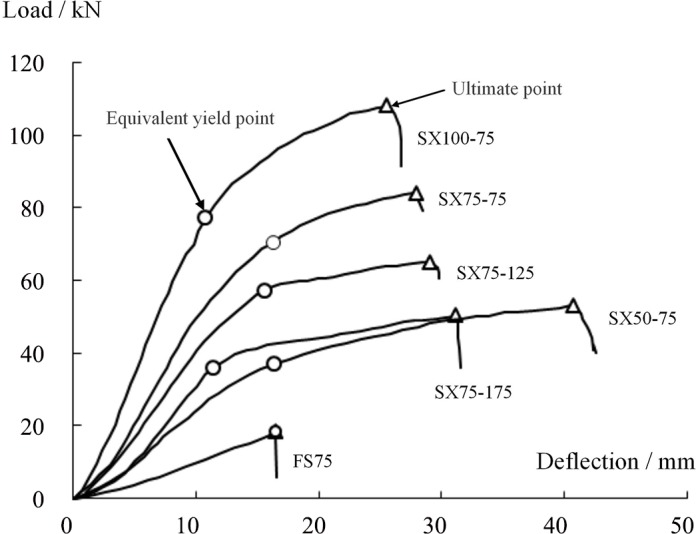
Load-deflection curves of the specimens.